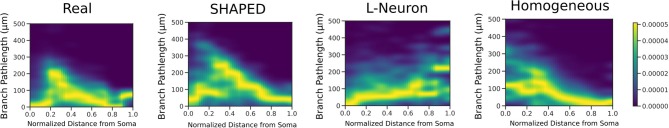
2D heatmaps displaying the conditional relationship between branch pathlength and distance from the soma. SHAPED is able to better capture the non-linear relationship observed in the real granule cell population, which is not as evident in the L-Neuron or homogeneous rate populations.